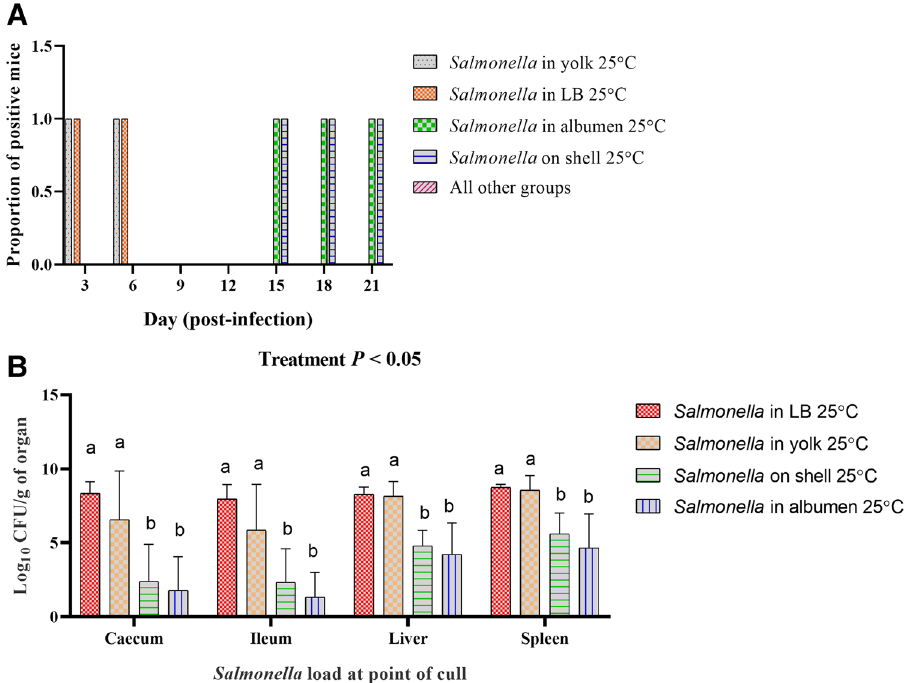
Figure 7. Fecal shedding profile and Salmonella load in organs of mice challenged with egg components containing Salmonella Typhimurium. ( A ). Qualitative assessment of feces for Salmonella . ( B ). Load of Salmonella in caecum, ileum, liver and spleen of challenged mice on day of cull. Except of four, the rest of the treatment groups (Table 1) did not shed Salmonella in the feces until the termination of the trial on day 21 p.i. Treatment groups that received Salmonella in yolk and LB were euthanized on day 6 and day 8 respectively due to the development of clinical salmonellosis. Salmonella was not recovered from any of the organs collected from the remaining treatment groups that did not shed Salmonella in the feces. Within each organ, different superscripts show significant differences (P < 0.05). In Panel ( A ) of the figure, values are proportion of Salmonella positive fecal samples, while in Panel ( B ), values are the mean of log 10 CFU ±